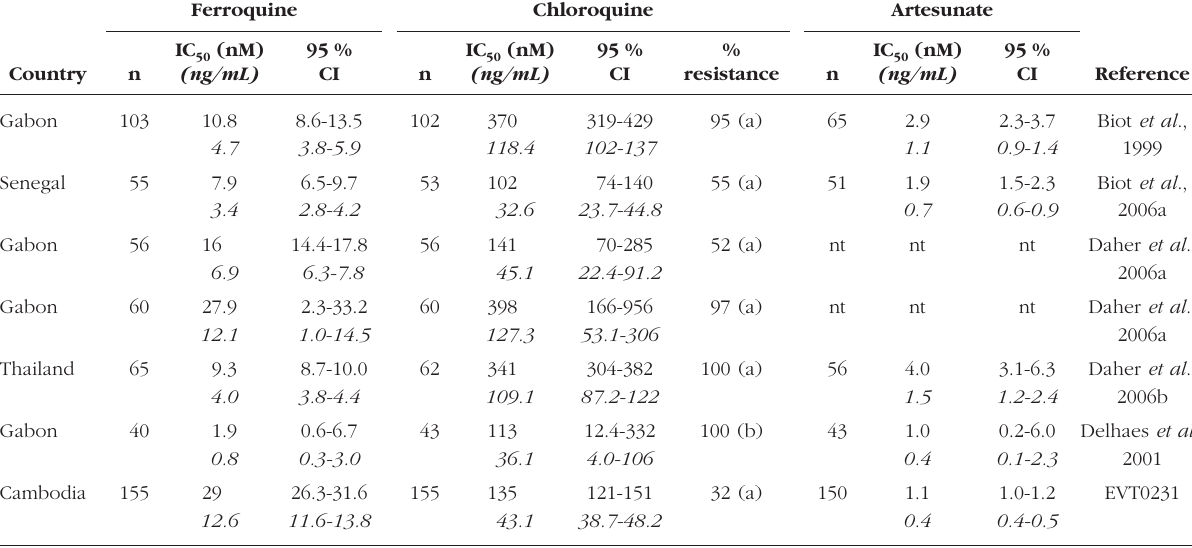
Table I. – Effect of FQ (SSR97193 – IC and 95 % confidence intervals) on P. falciparum clinical isolates from different 50